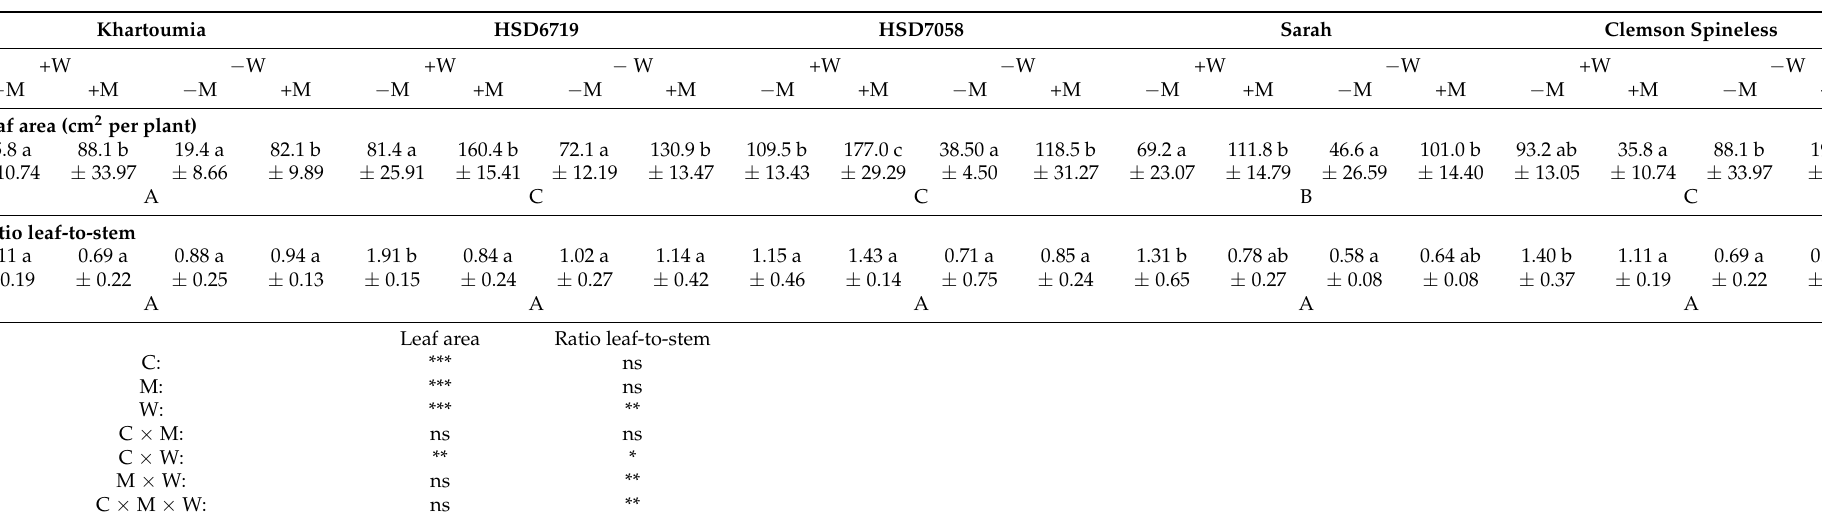
Table A2. Leaf area (in cm 2 per plant) and ratio of leaf:stem (based on DW) of the five okra cultivars. Plants were non-inoculated ( − M) or inoculated (+M) with R. irregulare. Substrate water content was either maintained at 20% (+W) or 10% w / w ( − W). For statistics, refer to the text for Figure